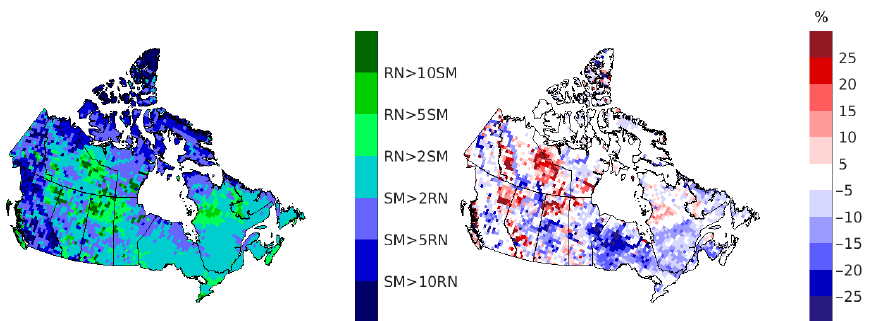
Figure 4. Relative average snowmelt and rainfall contribution in GEM for the 15 largest streamflow events during the 1981–2010 period ( left ). Difference in rainfall contribution with respect to the average rainfall contribution during the 150 largest streamflow events ( right ).